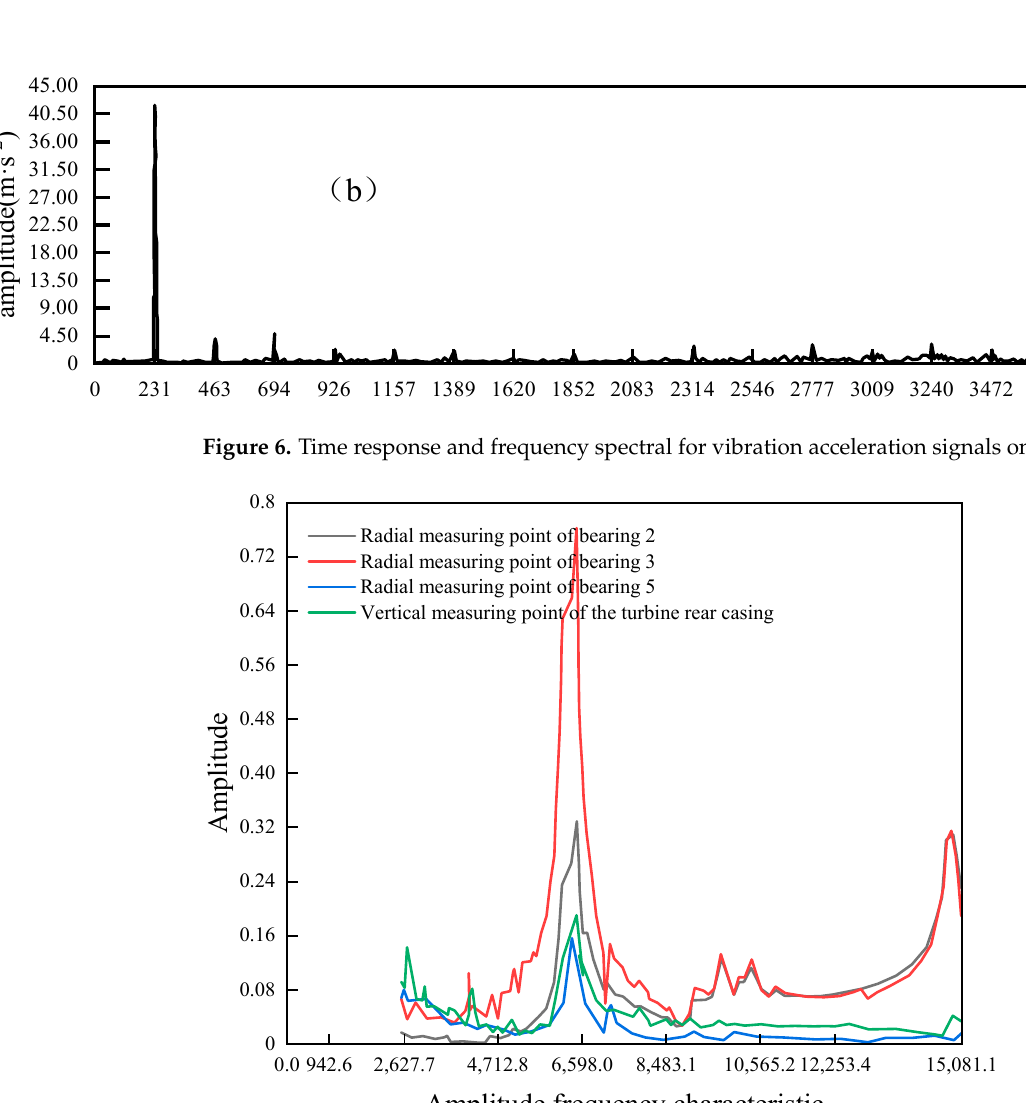
Figure 7. Vibrational transmission ratio amplitude frequency characteristics for the casing.